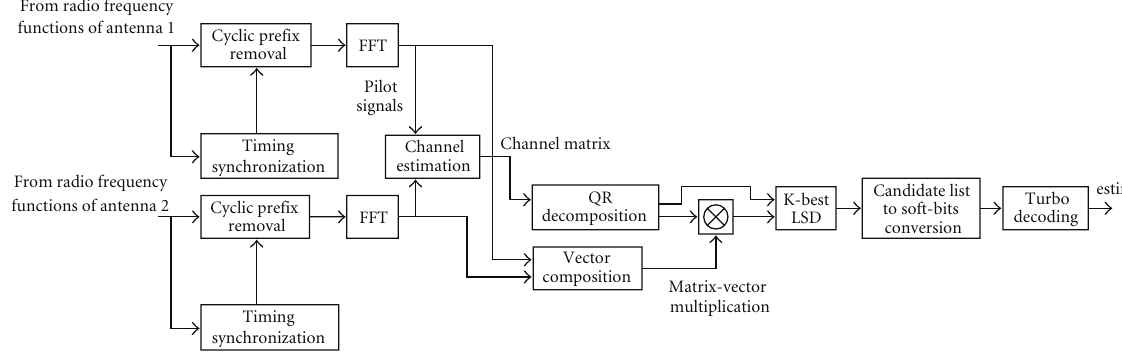
Figure 1: A simplified block diagram of baseband processing of a two-antenna MIMO-OFDM receiver using K -best LSD for symbol detection. ASP implementations for FFT, QR decomposition, list sphere detection, turbo decoding, and multiplications are considered in this